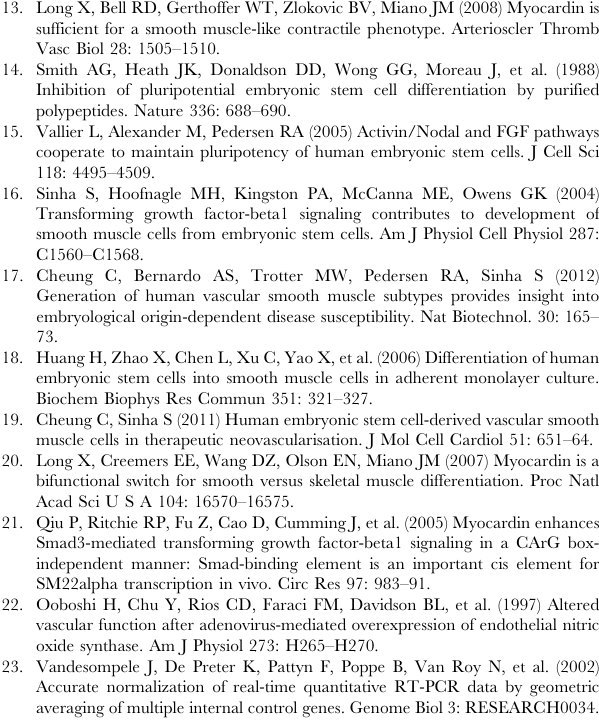
Figure S1 Optimisation of adenoviral titres for trans- duction. Embryoid bodies were transduced using a range of Ad- LacZ titres (0.5 6 10 6 to 1.5 6 10 7 pfu/ml) and then stained with X- gal to identify optimal viral titres to ensure maximal transduction. Figure S2 Myocardin overexpression promotes a con- tractile SMC appearance in embryoid bodies. Effects of Ad-LacZ (A and C) or Ad-Myo (B and D) treatment from day 10 to day 28 on the appearance of cells in the embryoid body outgrowth. Phase contrast images were taken at day 28. Figure S3 Mesoderm and cardiac genes are upregulated by myocardin overexpression. Embryoid bodies were treated with no virus, Ad-LacZ or Ad-Myo from day 10 to day 28 and then harvested for RNA. Real time RT-PCR was used to quantify markers of ectoderm, endoderm and mesoderm (A). Markers of skeletal muscle (B) and cardiac muscle (C) were also investigated. RT-PCR data represent means from three independent experi-